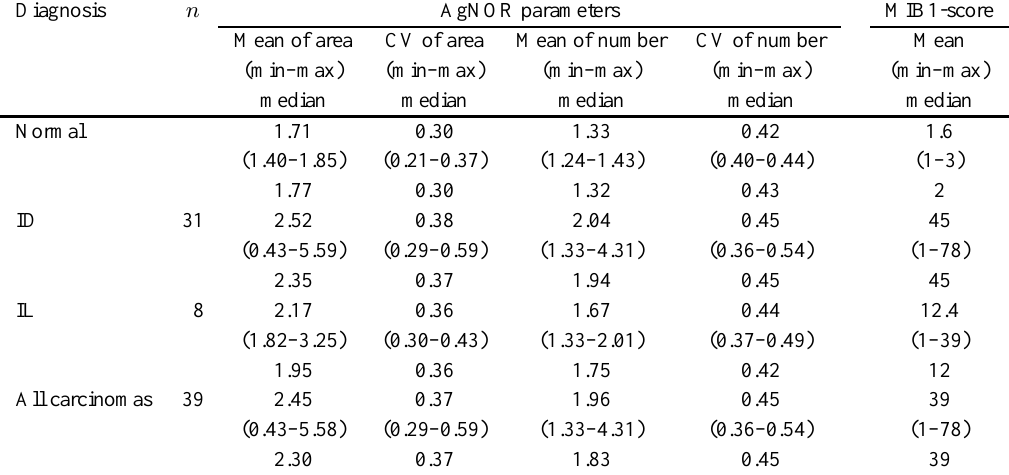
Standardised AgNOR parameters and MIB1 score in normal and carcinoma samples of the breast